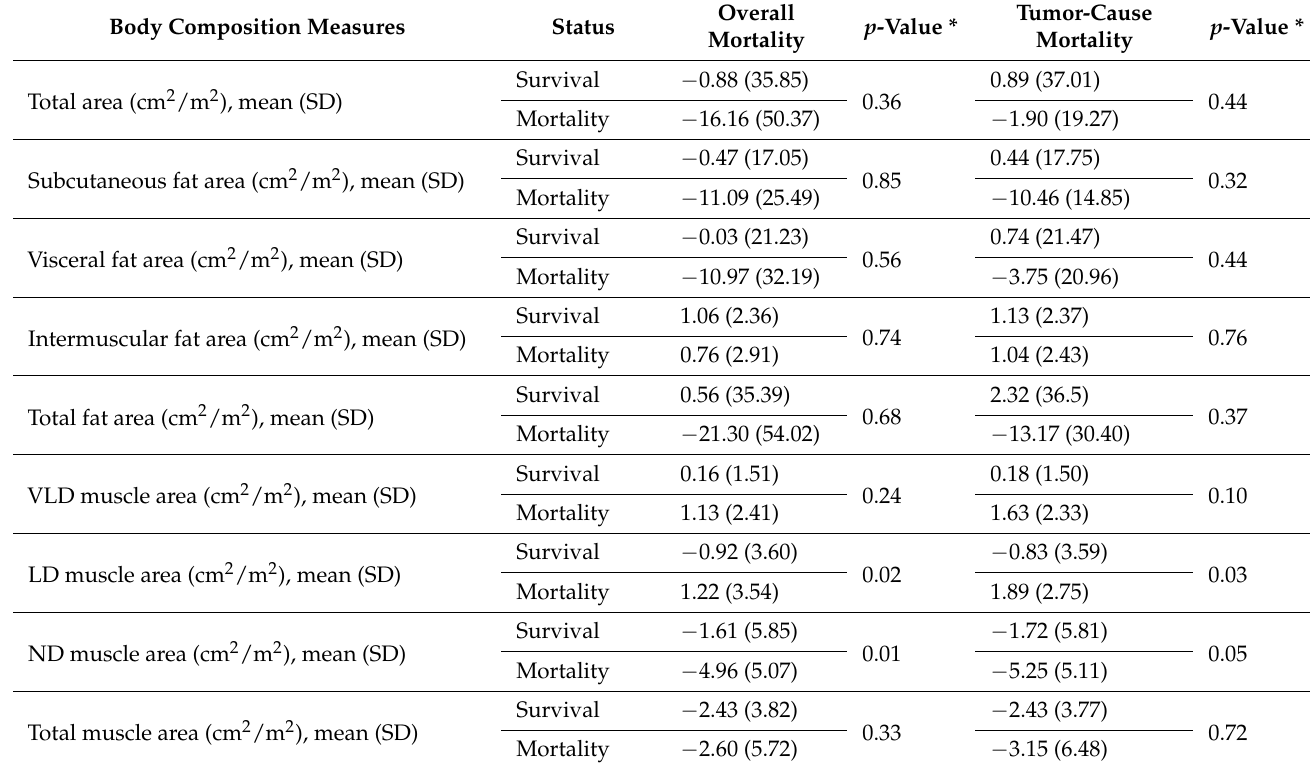
Table 3. Logistic regression output correcting follow-up body composition measures and their distribution between survival and overall mortality and survival and tumor-cause-related